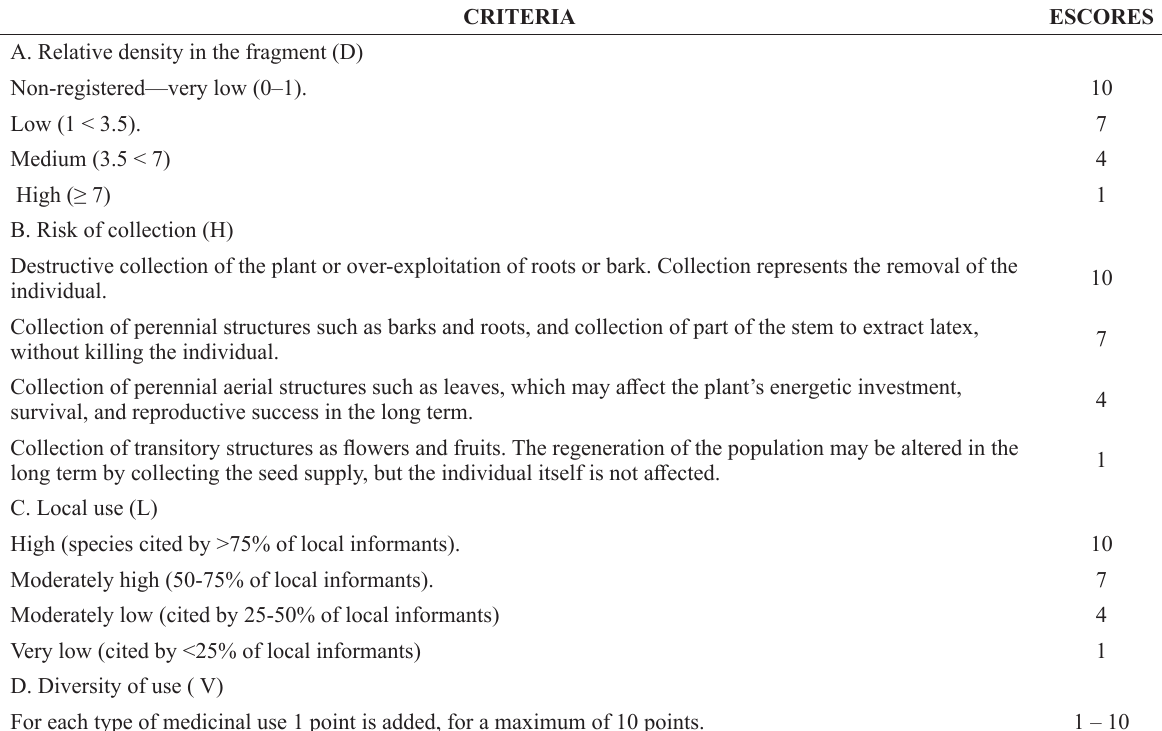
Criteria and scores used to calculate priorities conservation of medicinal plants arising of the phytosociological survey in the community Nazaré,